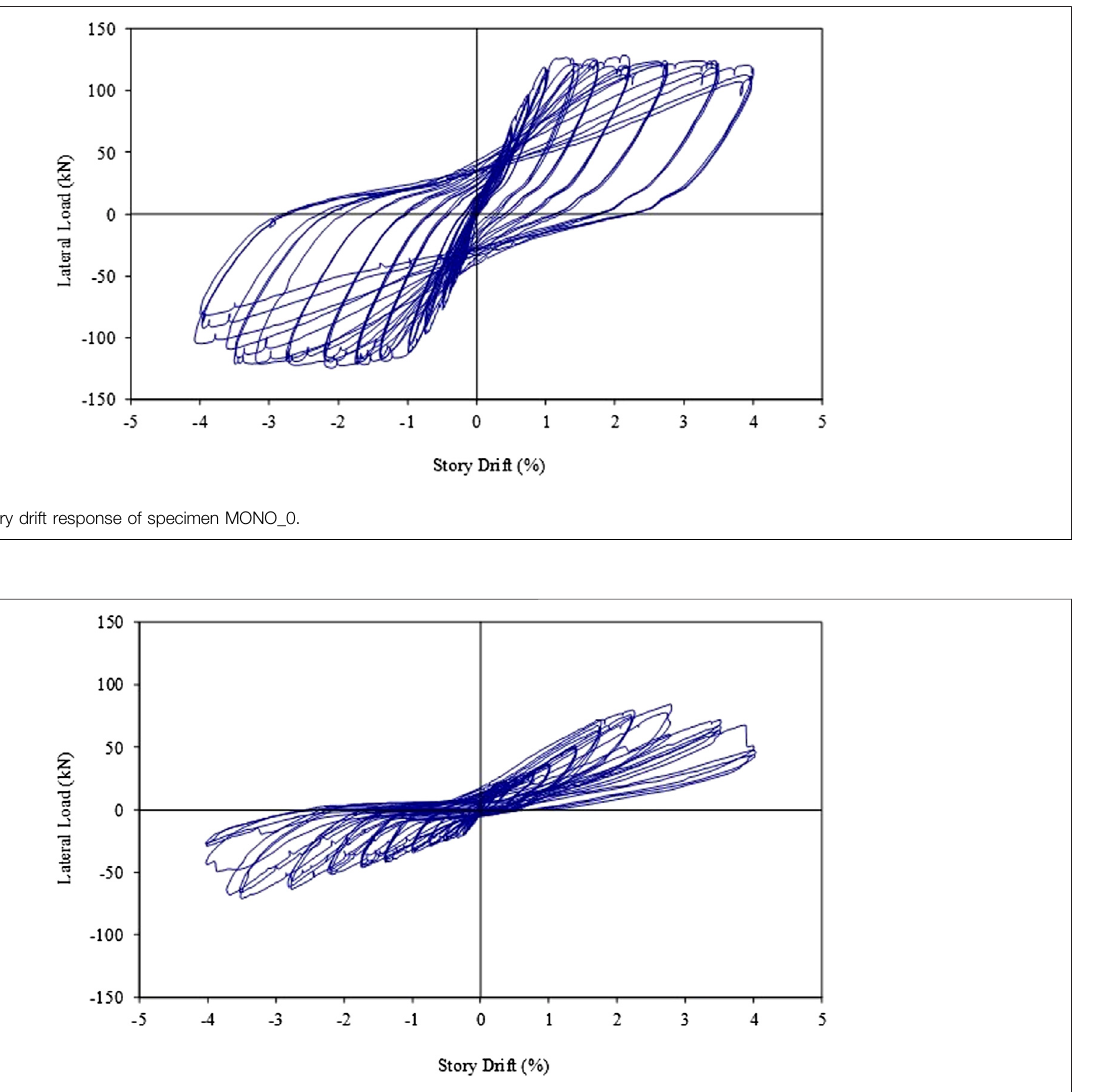
FIGURE 7 | Load — story drift response of specimen